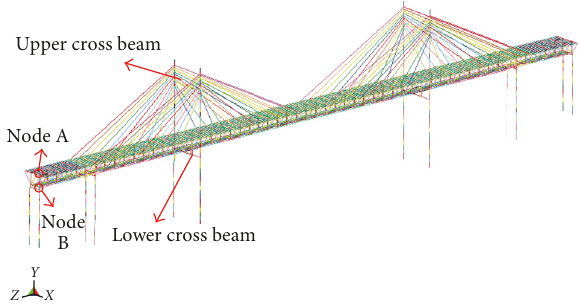
Figure 7: Finite element